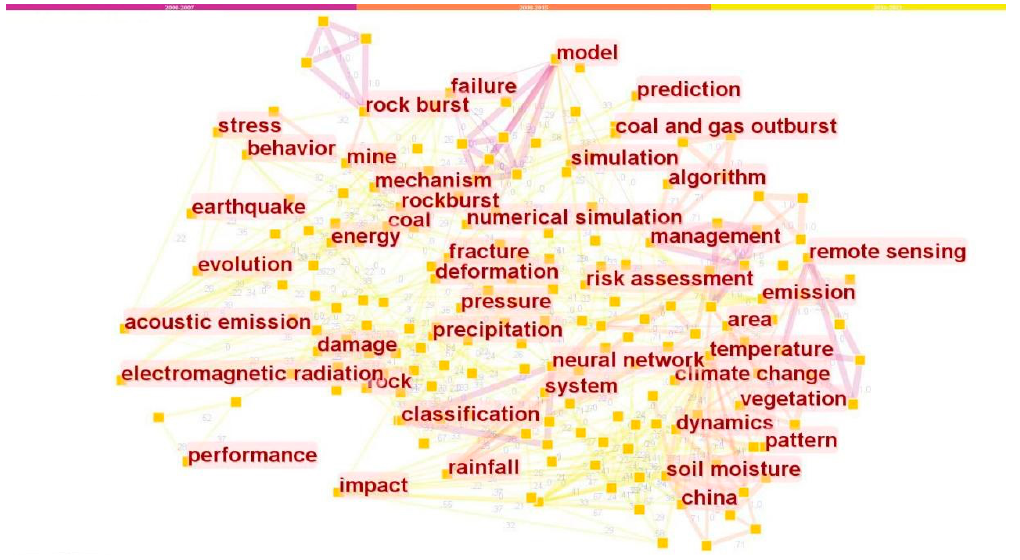
Figure 2. The knowledge map of China’s dynamic disaster monitoring and early warning interna- tional research hotspots (2000–2021) (node type).